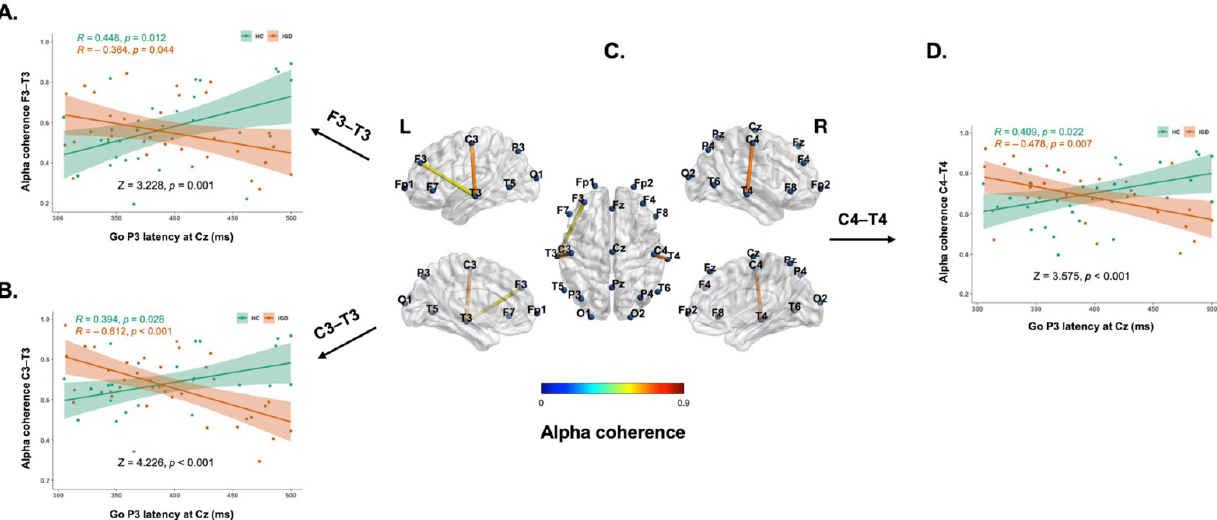
Figure 2. Inverse patterns of correlations between alpha coherence in the left fronto-temporal (F3-T3) ( A ), centro-temporal (C3-T3) ( B ) and right centro-temporal (C4-T4) ( D ) areas and the latency of Go-P3 in the healthy control (HC) and Internet gaming disorder (IGD) groups. HC people had positive correlation between alpha coherence and the latency of Go-P3 elicited with the Go/Nogo task, whereas IGD patients had negative correlation between alpha coherence and the latency of P3. ( C ) Cortical representation of the alpha coherence. The lines represent alpha coherence between electrode regions. (Left) Lateral and medial views of left hemisphere for fronto-temporal and centro-temporal alpha coherence. (Center) Dorsal view of inter and intra-hemispheric alpha coherence. (Right) Lateral and medial views of right hemisphere cento- temporal alpha coherence.